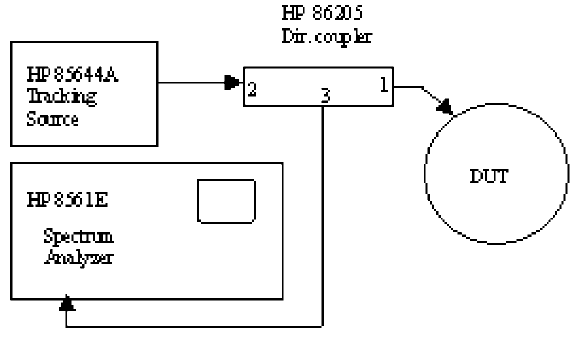
FIG. 3. Scheme for the reflection coefficient measurement.